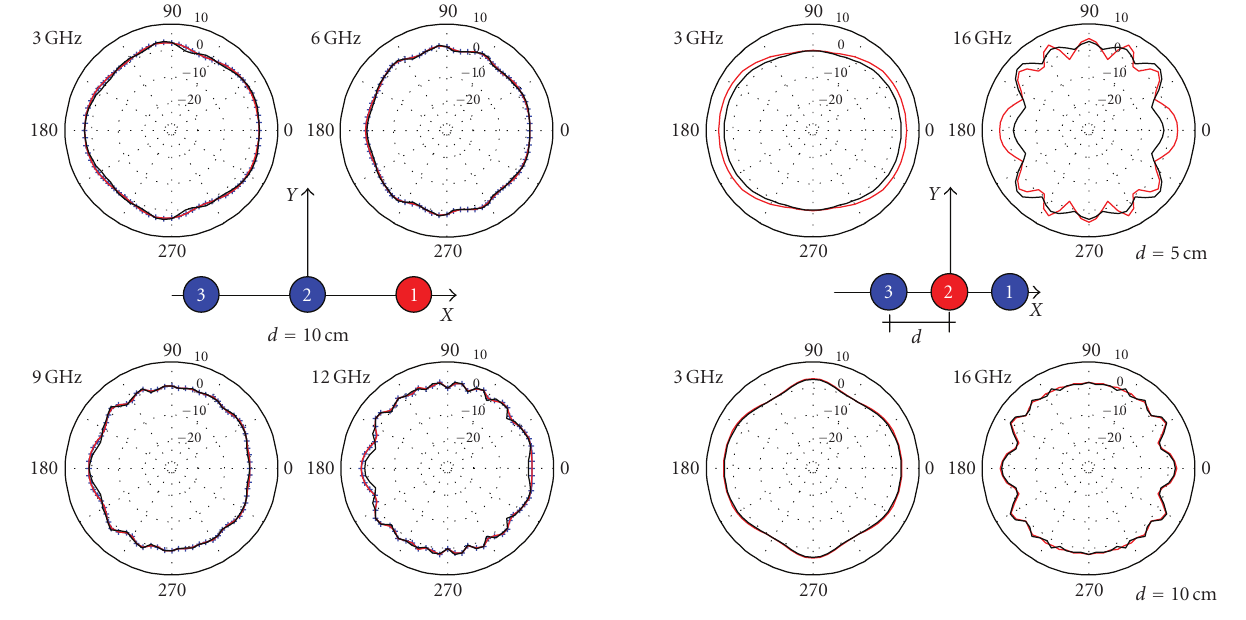
Figure 14: Three-bicone linear array ( d = 10 cm) with feeding on antenna 1 and open circuit on antennas 2 and 3. Expected azimuth (X-Y plane) radiation pattern (black line), and SC approximation with all single and multiple scattering terms (blue marker), SC ap- proximation with only single scattering on antenna 2 (red line).